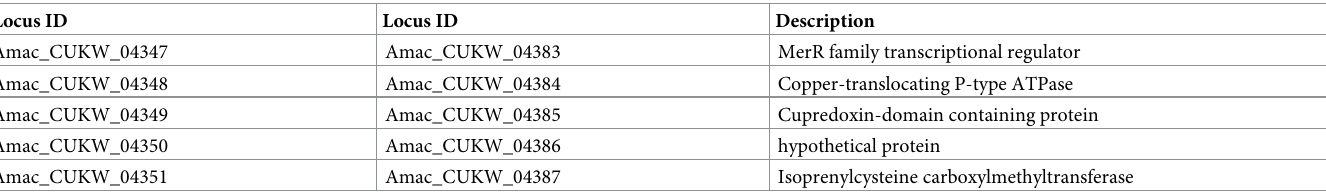
Table 8. CUKW loci IDs for duplicated copA gene